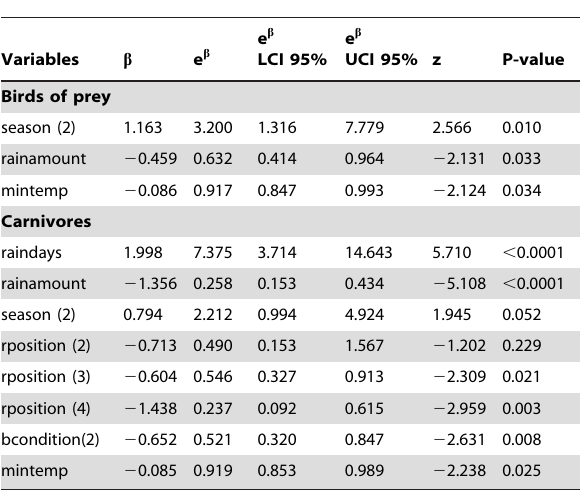
Table 7. Multivariate Cox hazards models for Birds of prey and Carnivores ( b : coefficients, e b : hazards ratio, e b LCI 95%: 95% lower confidence interval for hazards ratio, e b UCI 95%: 95% upper confidence interval for hazards ratio, z: Wald test, P-value: significance of Wald test, for variables definition, see table